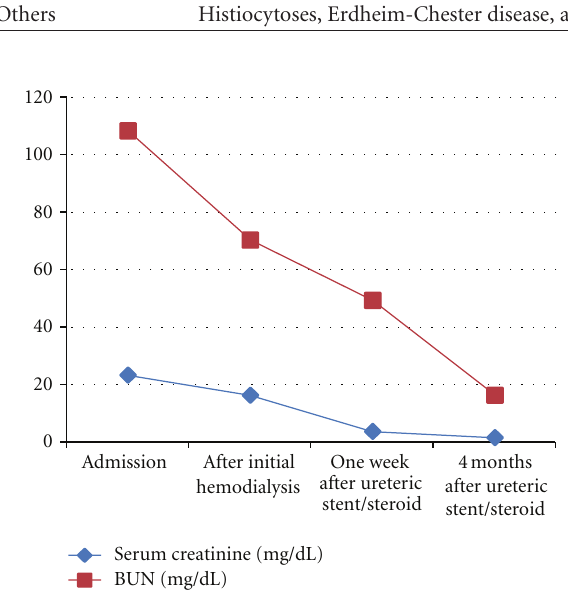
Figure 2: Patient’s BUN and serum Cr levels trend.